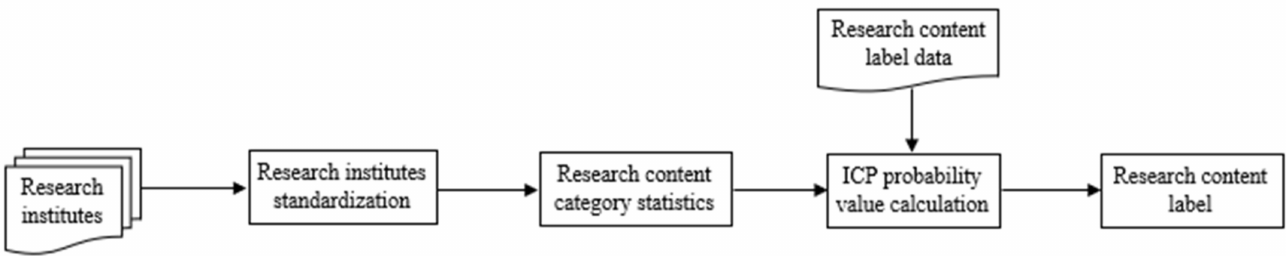
Figure 4. Features mapping process for research